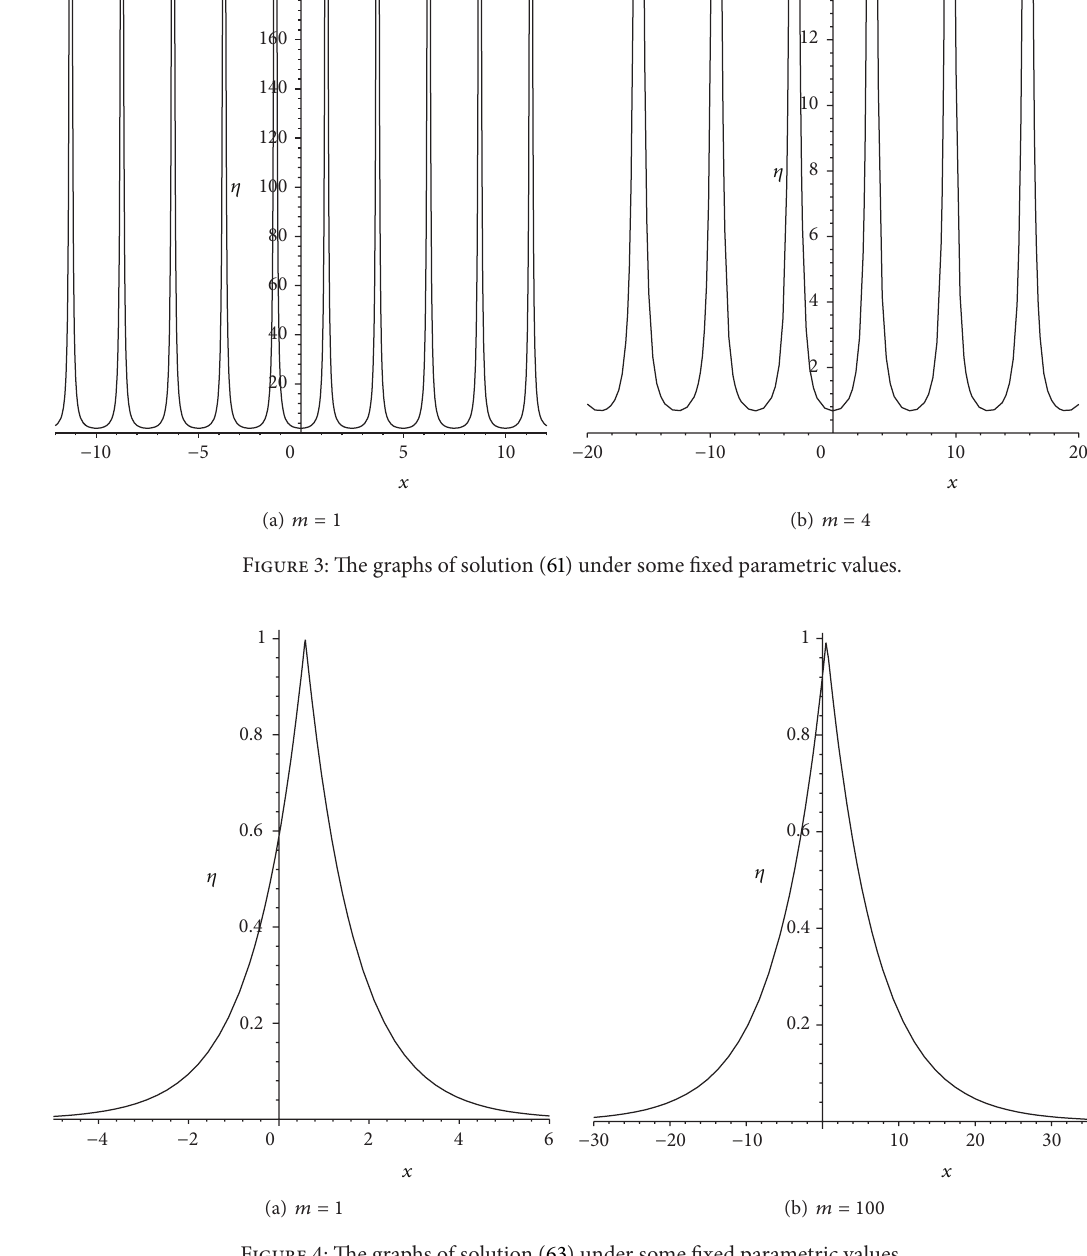
Figure 4: The graphs of solution (63) under some fixed parametric